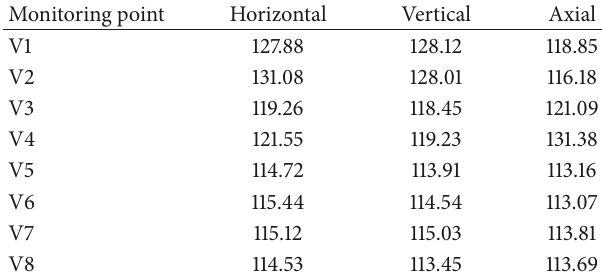
Table 2: Vibration acceleration in different monitoring point